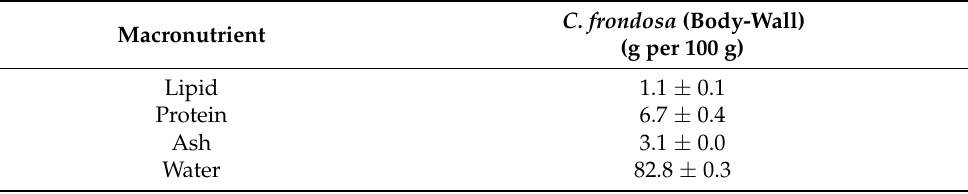
Table 1. Proximate composition of lipid, protein, ash and water (g per 100 g wet weight) of orange- footed sea cucumber ( Cucumaria frondosa ) body-wall (average ± SD, n =